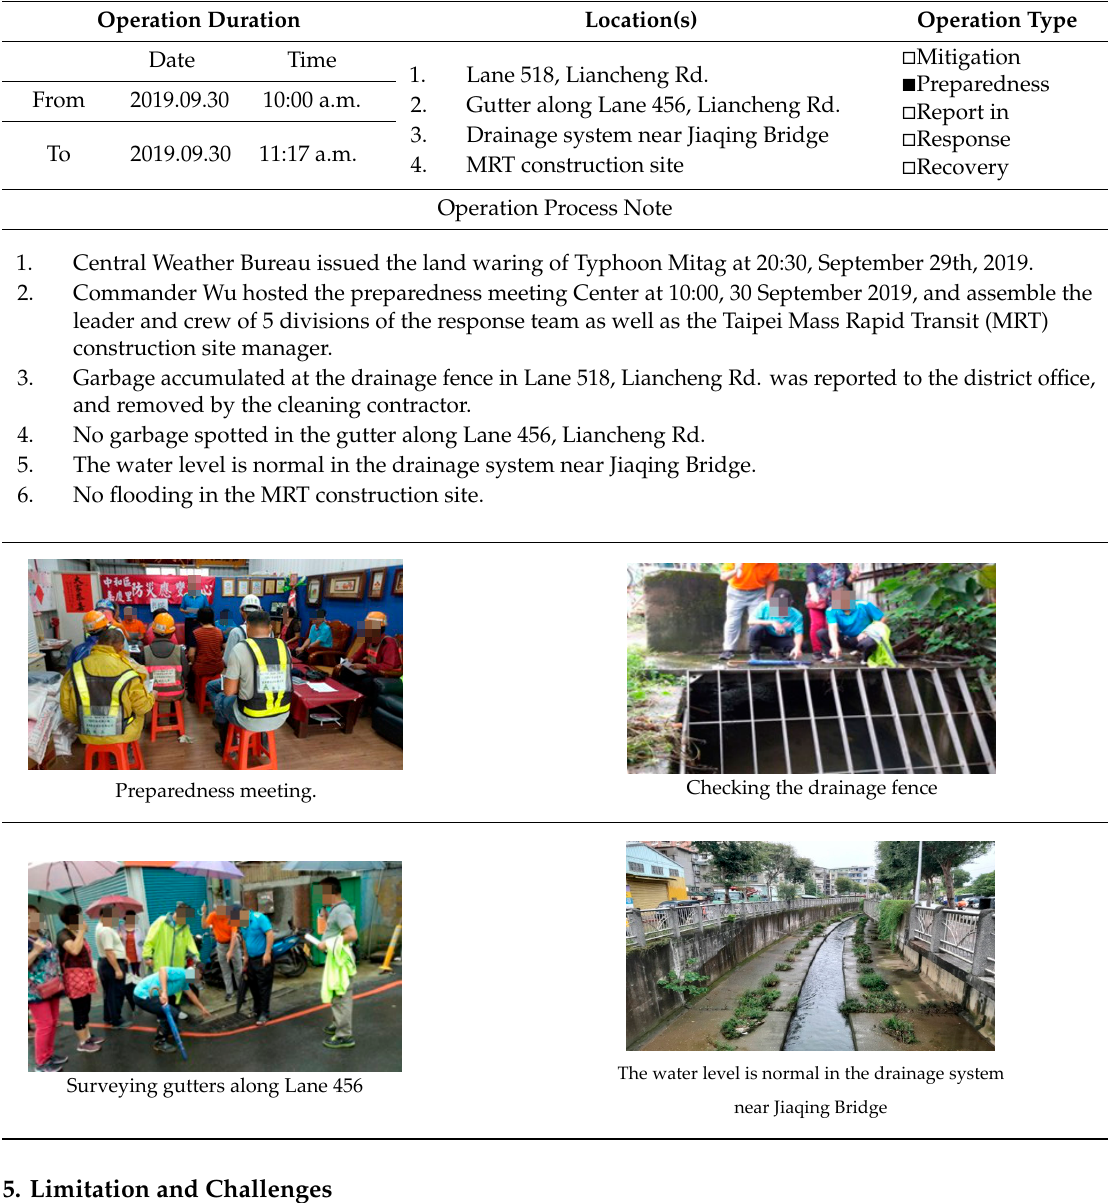
Table 4. Resilience Community Performance Tracking Table (Example).